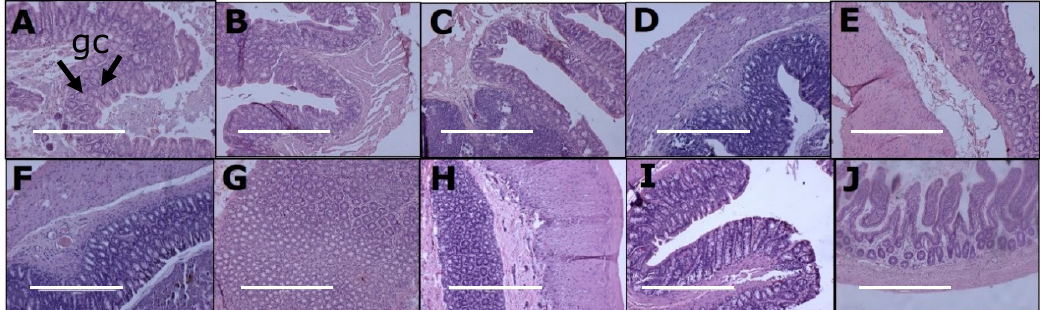
Figure 5. Effects of curcumin on structure and goblet cells (“gc”) in the colon using haematoxylin and eosin stain in corn starch diet-fed rats ( A ), corn starch diet-fed rats given 5 mg / kg / day curcumin ( B ), corn starch diet-fed rats given 100 mg / kg / day curcumin ( C ), corn starch diet-fed rats given 5 mg / kg / day curcumin nanoparticles ( D ), corn starch diet-fed rats given blank nanoparticles (E), high-carbohydrate, high-fat diet-fed rats ( F ), high-carbohydrate, high-fat diet-fed rats given 5 mg / kg / day curcumin ( G ), high-carbohydrate, high-fat diet-fed rats given 100 mg / kg / day curcumin ( H ), high-carbohydrate, high-fat diet-fed rats given 5 mg / kg / day curcumin nanoparticles ( I ) and high-carbohydrate, high-fat diet-fed rats given blank nanoparticles ( J ). The white bar is 200 µ m.